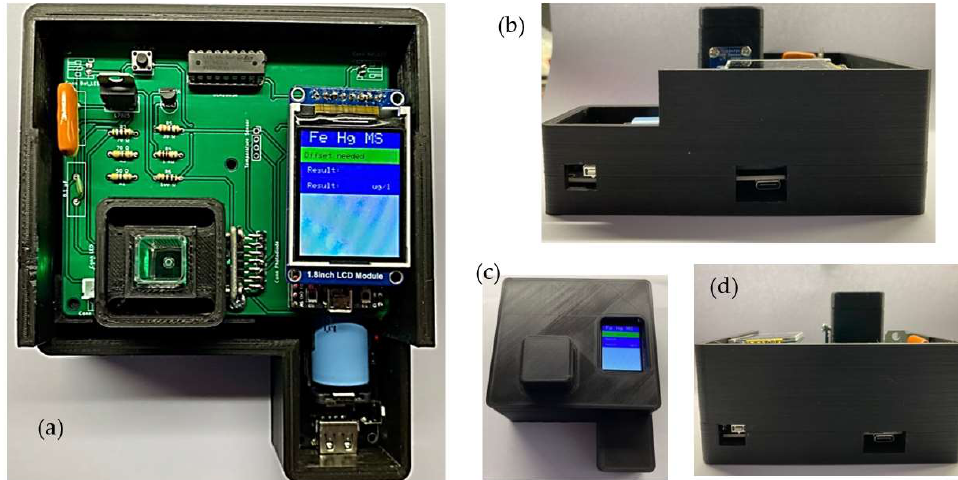
Figure 2. ( a ) Top view of final version of developed IMS without top cover; ( b ) right view; ( c ) top view of IMS fully assembled, with top cover and cap cuvette cover; ( d ) back view of system.